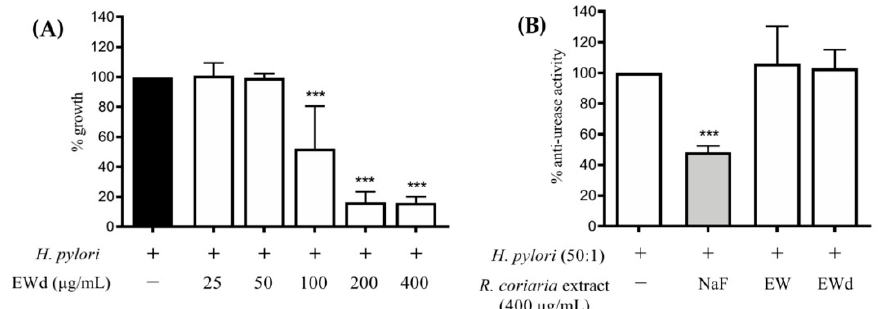
Figure 8. ( A ): effects of Rhus coriaria L. ethanol-water digested extract (EWd) on H. pylori growth. The data are expressed in terms of growth inhibition of the bacterium compared to the control with only H. pylori (incubation time: 72 h), which was arbitrarily assigned the value of 100%. The reference antibiotic used was tetracycline 0.125 µ g/mL (100% inhibition). ( B ): anti-urease activity of Rhus coriaria L. ethanol-water not digested (EW) and digested (EWd) extracts compared with the reference compound (grey color) sodium fluoride (NaF) 1M ( − 52%). *** p < 0.001. R. coriaria , Rhus coriaria .